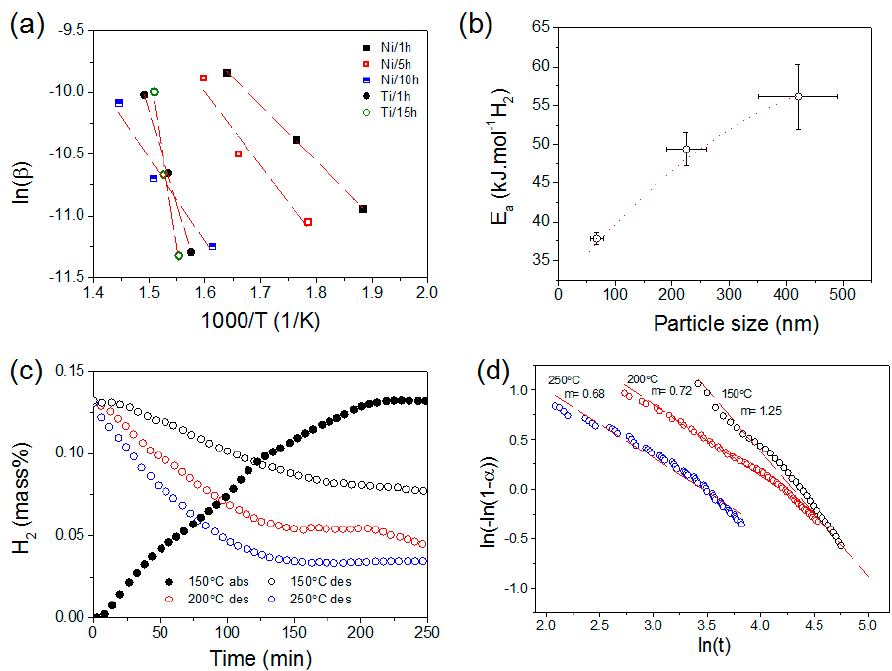
Figure 6. ( a ) Kissinger plot related to the hydrogen desorption from the magnesium nanoparticles deposited on Ni and Ti; ( b ) associated activation energy (E a ) as function of magnesium’s average particle size on the Ni substrates at 1, 5, and 10 h deposition time; ( c ) hydrogen kinetics for the material obtained after 5 h of electrochemical deposition; and ( d ) associated fit of the hydrogen kinetic desorption curves obtained at 150, 200, and 250 °C.